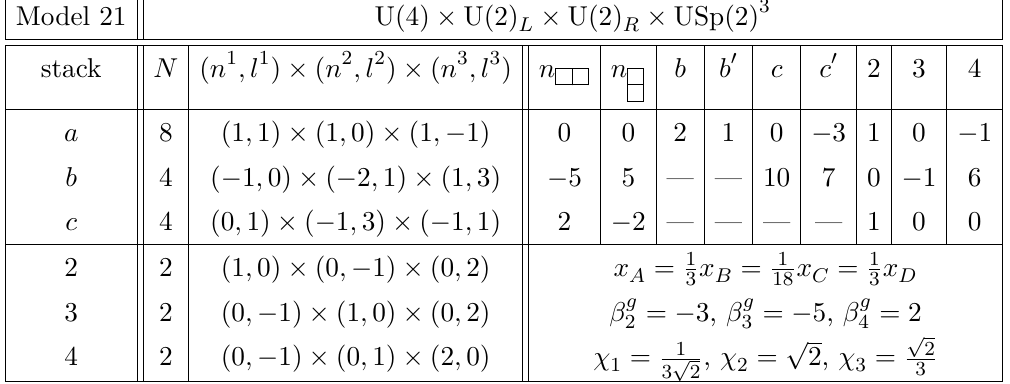
Table 28 . D6-brane configurations and intersection numbers of Model 21, and its MSSM gauge